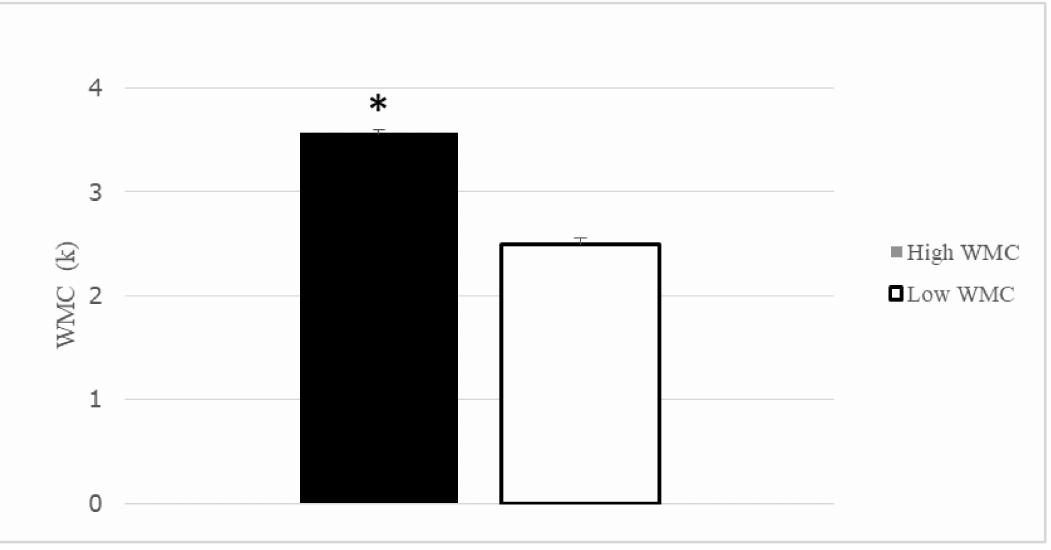
Figure 4. Working Memory Capacity (K index) for the Higher and Lower working memory capabilities (WMC) participants. Groups di ff ered in their WMC. Mean + SEM. * p <